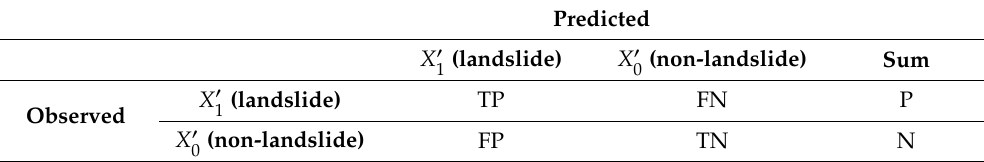
Table 4. Confusion matrix of landslide modeling by machine learning algorithms.